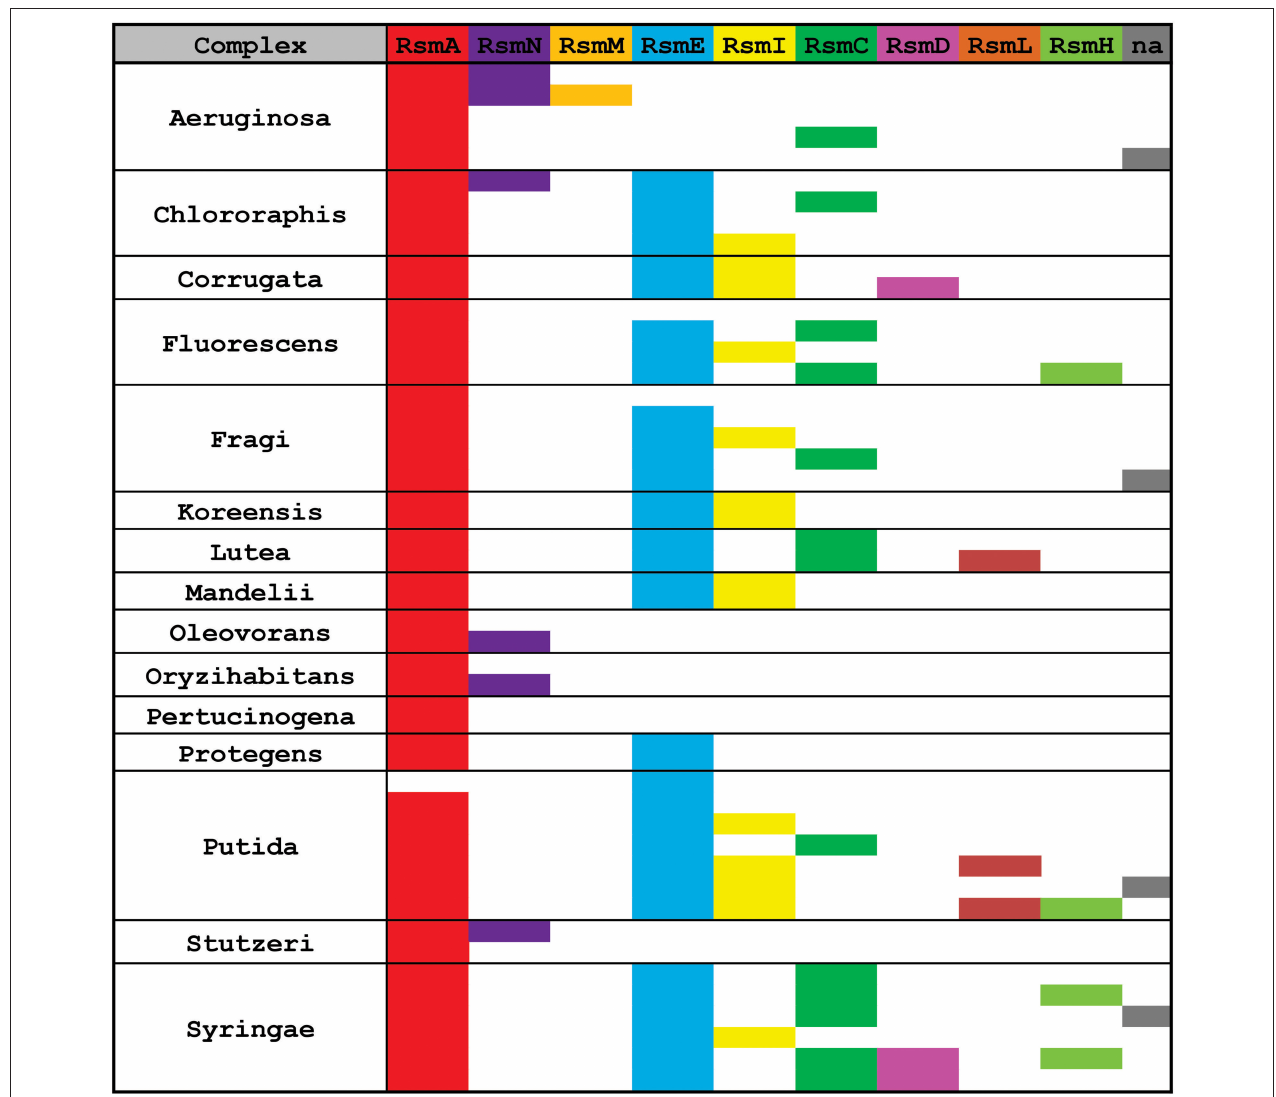
FIGURE 7 | Distribution of Rsm paralogues in the major Pseudomonas taxonomic subgroups. Within each subgroup, each row represents different species or strains displaying different combinations of alleles (see extended data in Supplementary Table 4 ). n.a., the sequence of the rsm paralogue could not be assigned with enough confidence to any of the 9